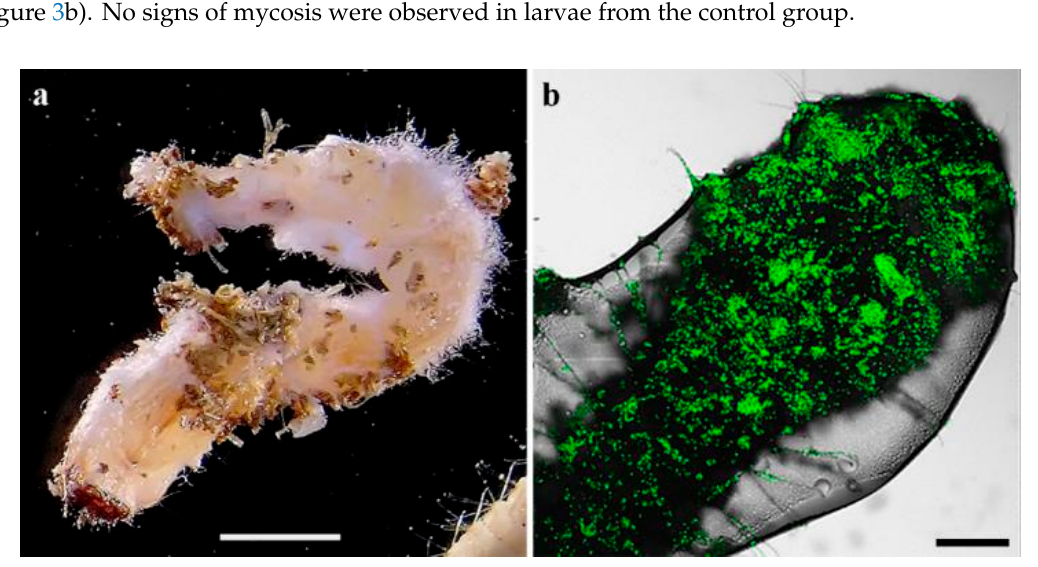
Table 4. Trial 2018: infestation, colonization, and gumming rates of C. tenebrionis larvae on potted rootstocks treated with Mb7-GFP premix, topsoil application, or untreated soil (control). Treatments